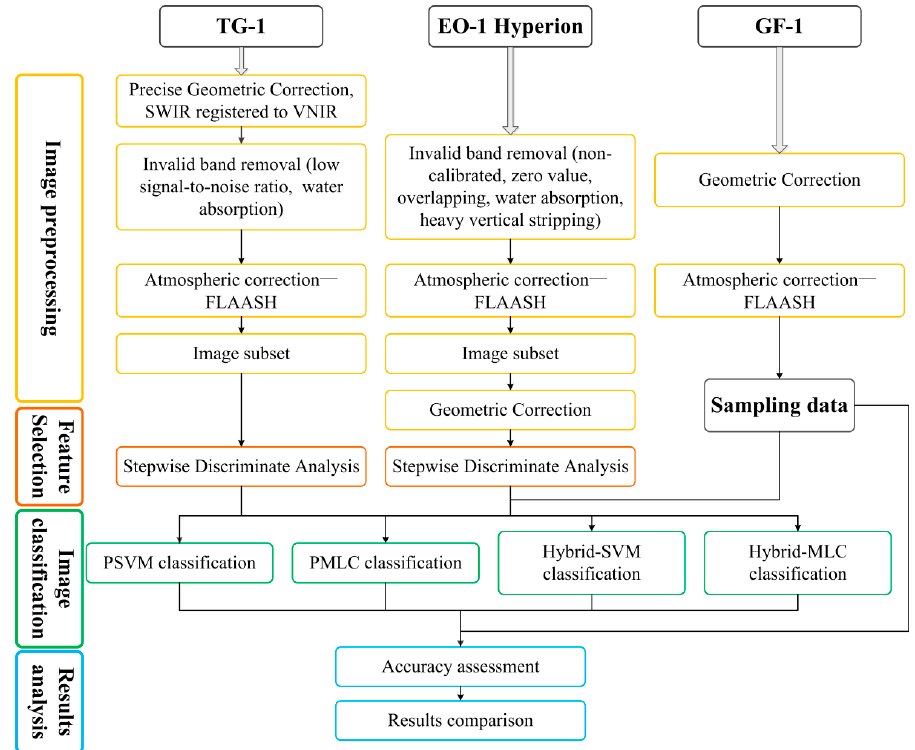
Figure 3. Overall process diagram of this research study.